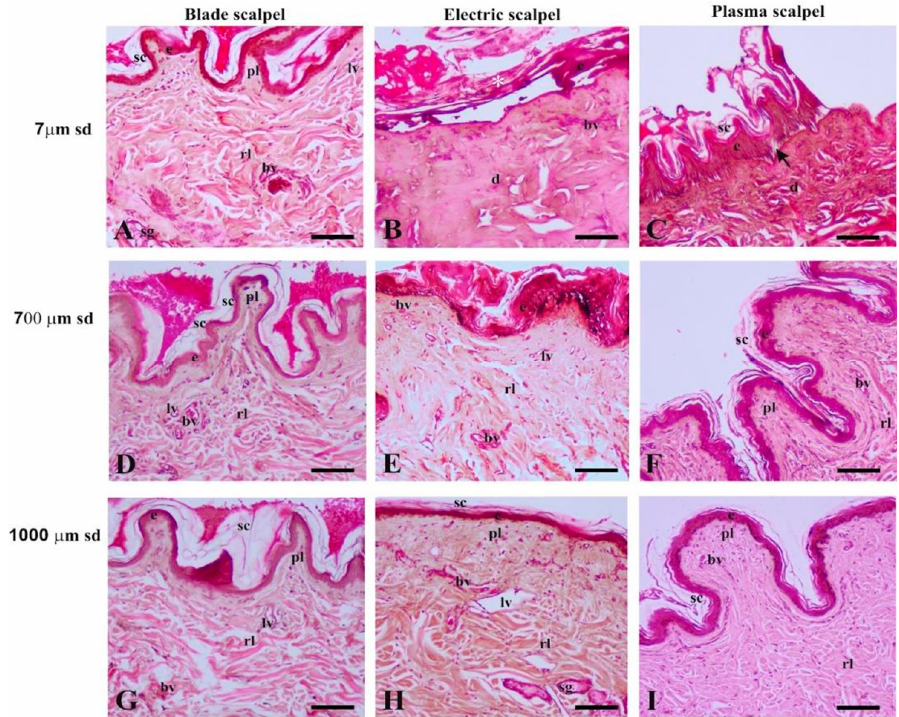
Figure 3 . Histological features of canine skin after incision with blade scalpel ( A,D,G ), electrosurgical scalpel ( B,E,H ), and plasma scalpel ( C,F,I ) at 7 µm (A,B,C), 700 µm (D,E,F), and 1000 µm (G,H,I) from the surgical diaeresis. bv, blood vessels; e, epidermis; lv, lymphoid vessel; rl, reticular layer of the dermis; sb, sebaceous gland; sc, stratum corneum; sd, distance from the surgical diaeresis; pl, papillar layer of the dermis; *, detached epidermis; arrow, detaching epidermis. Scale bars: 100 µm.